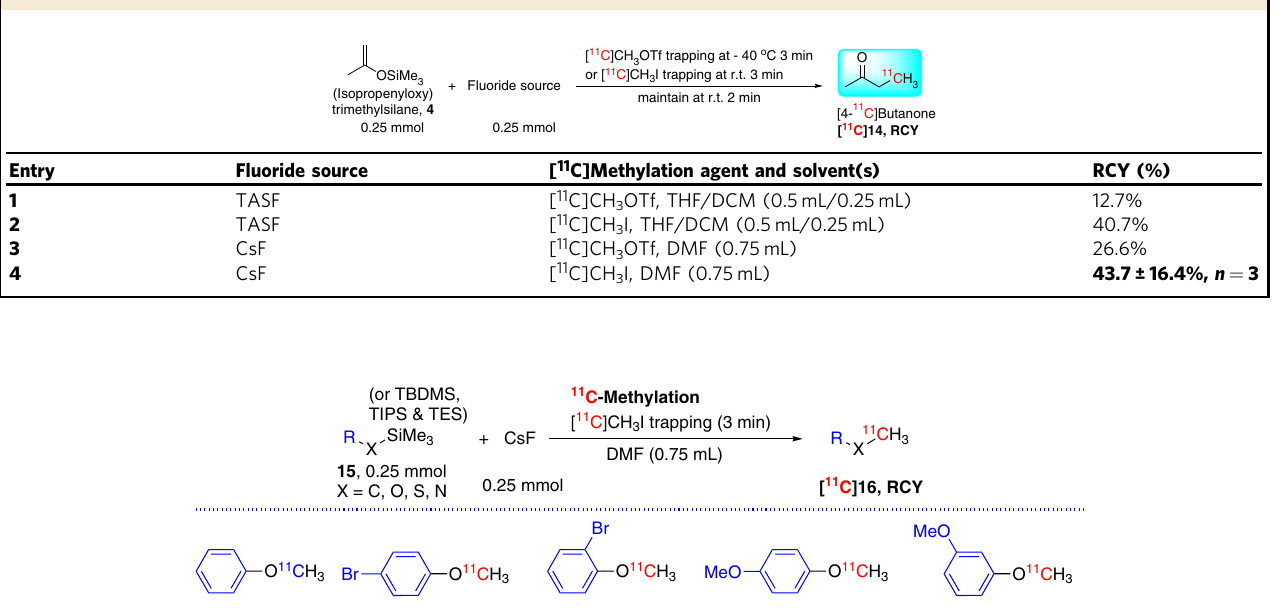
Table 1 FMDS 11 C-methylation reaction conditions screening.